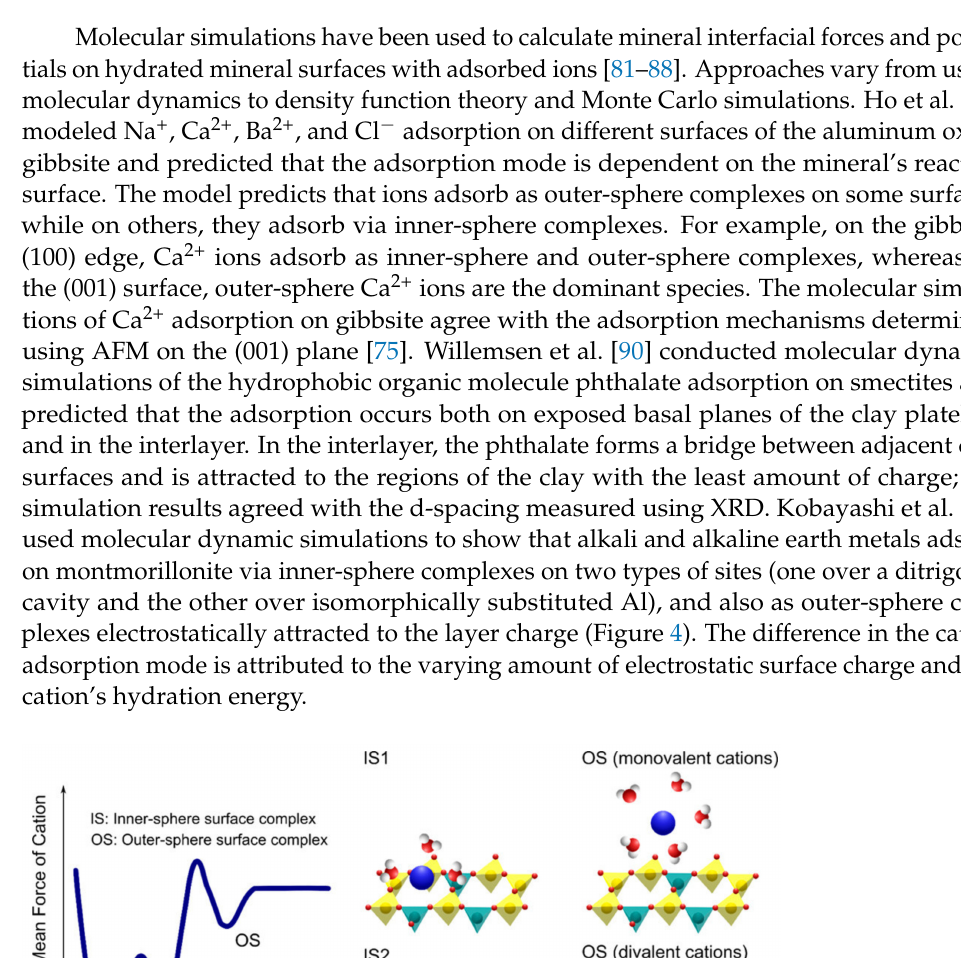
Figure 3. Illustration of atomic force microscopic imaging of mica surface showing cations adsorbed on charged surface sites. Adapted from Xian et al. [80] with permission.